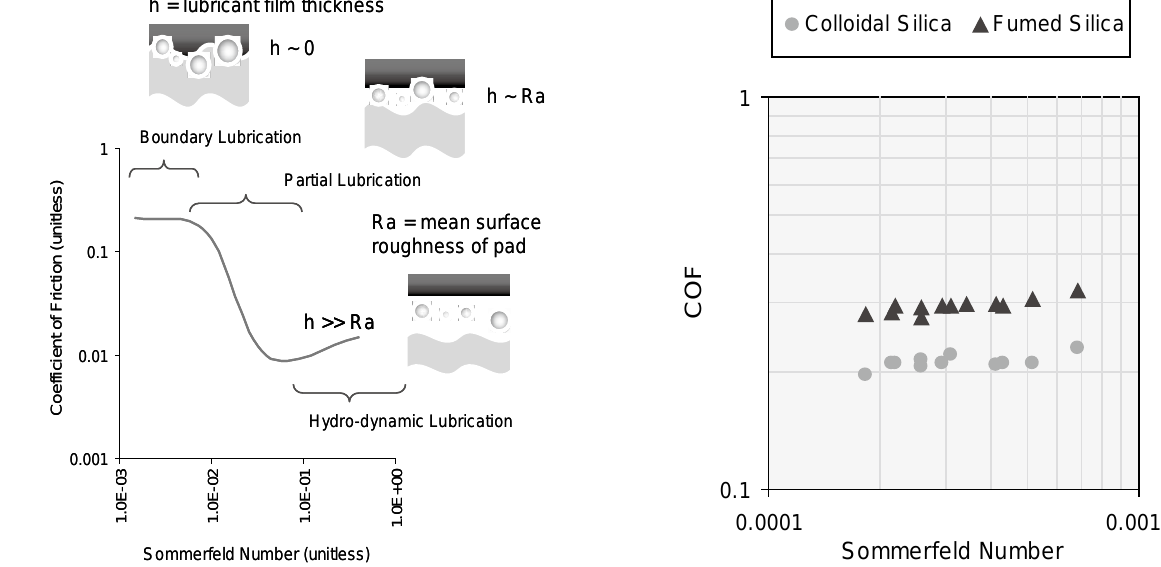
Fig.5 Comparison of COF values of Colloidal and Fumed silica slurries (Courtesy of Prof. Philipossian, The University of